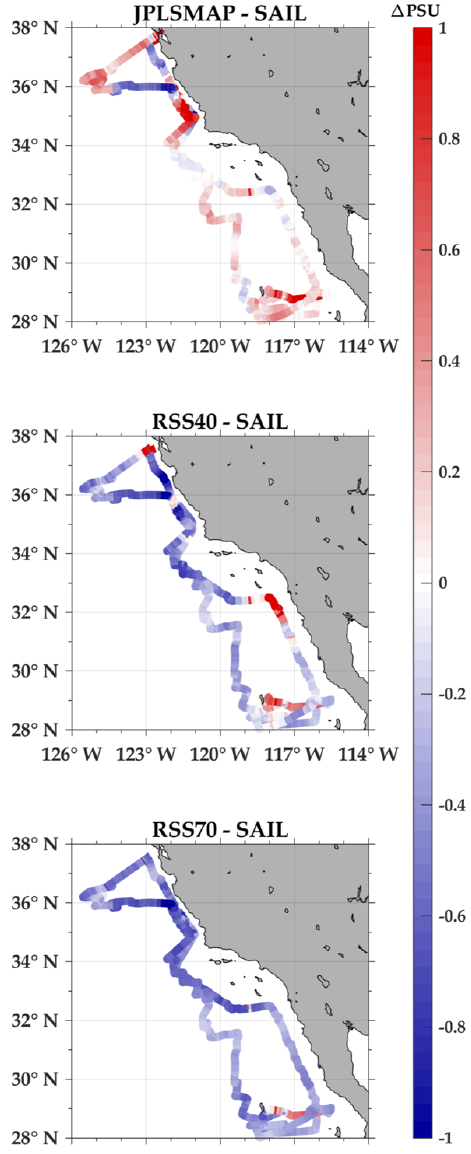
Figure 6. Difference plots for each of the remotely sensed SSS products and the Saildrone-derived